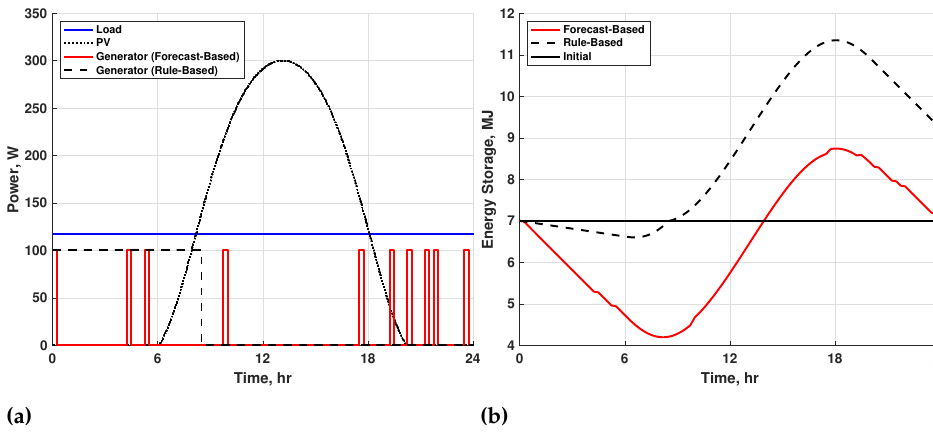
Figure 5. No stress case power ( a ) and energy storage ( b ).